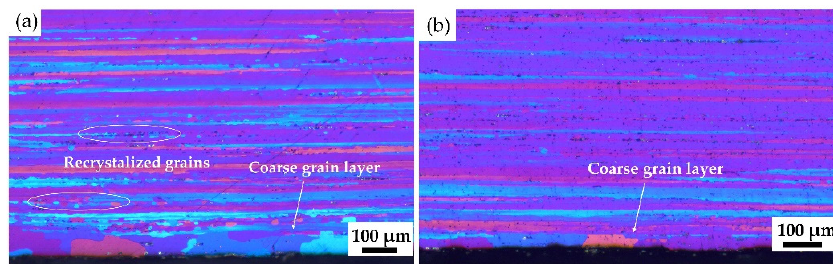
Figure 7. OM diagram of the solution treatment sheet edges of ( a ) P1 and ( b )